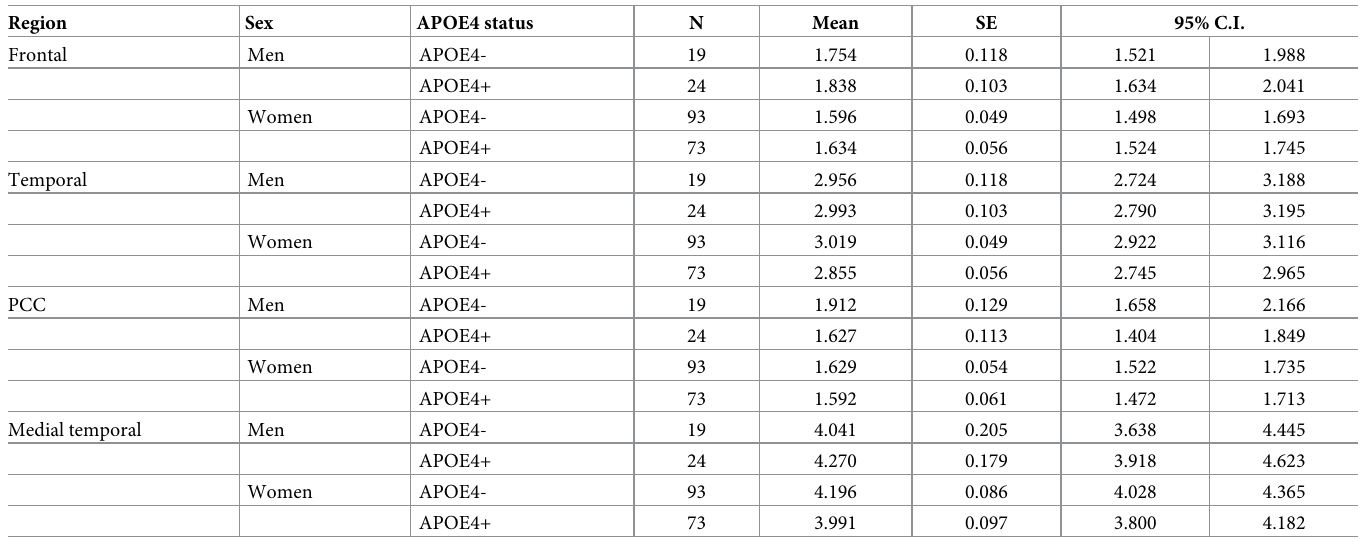
Table 5. Regional phosphomonoesters/phosphodiesters (PME/PDE) by sex and APOE4 status. Region